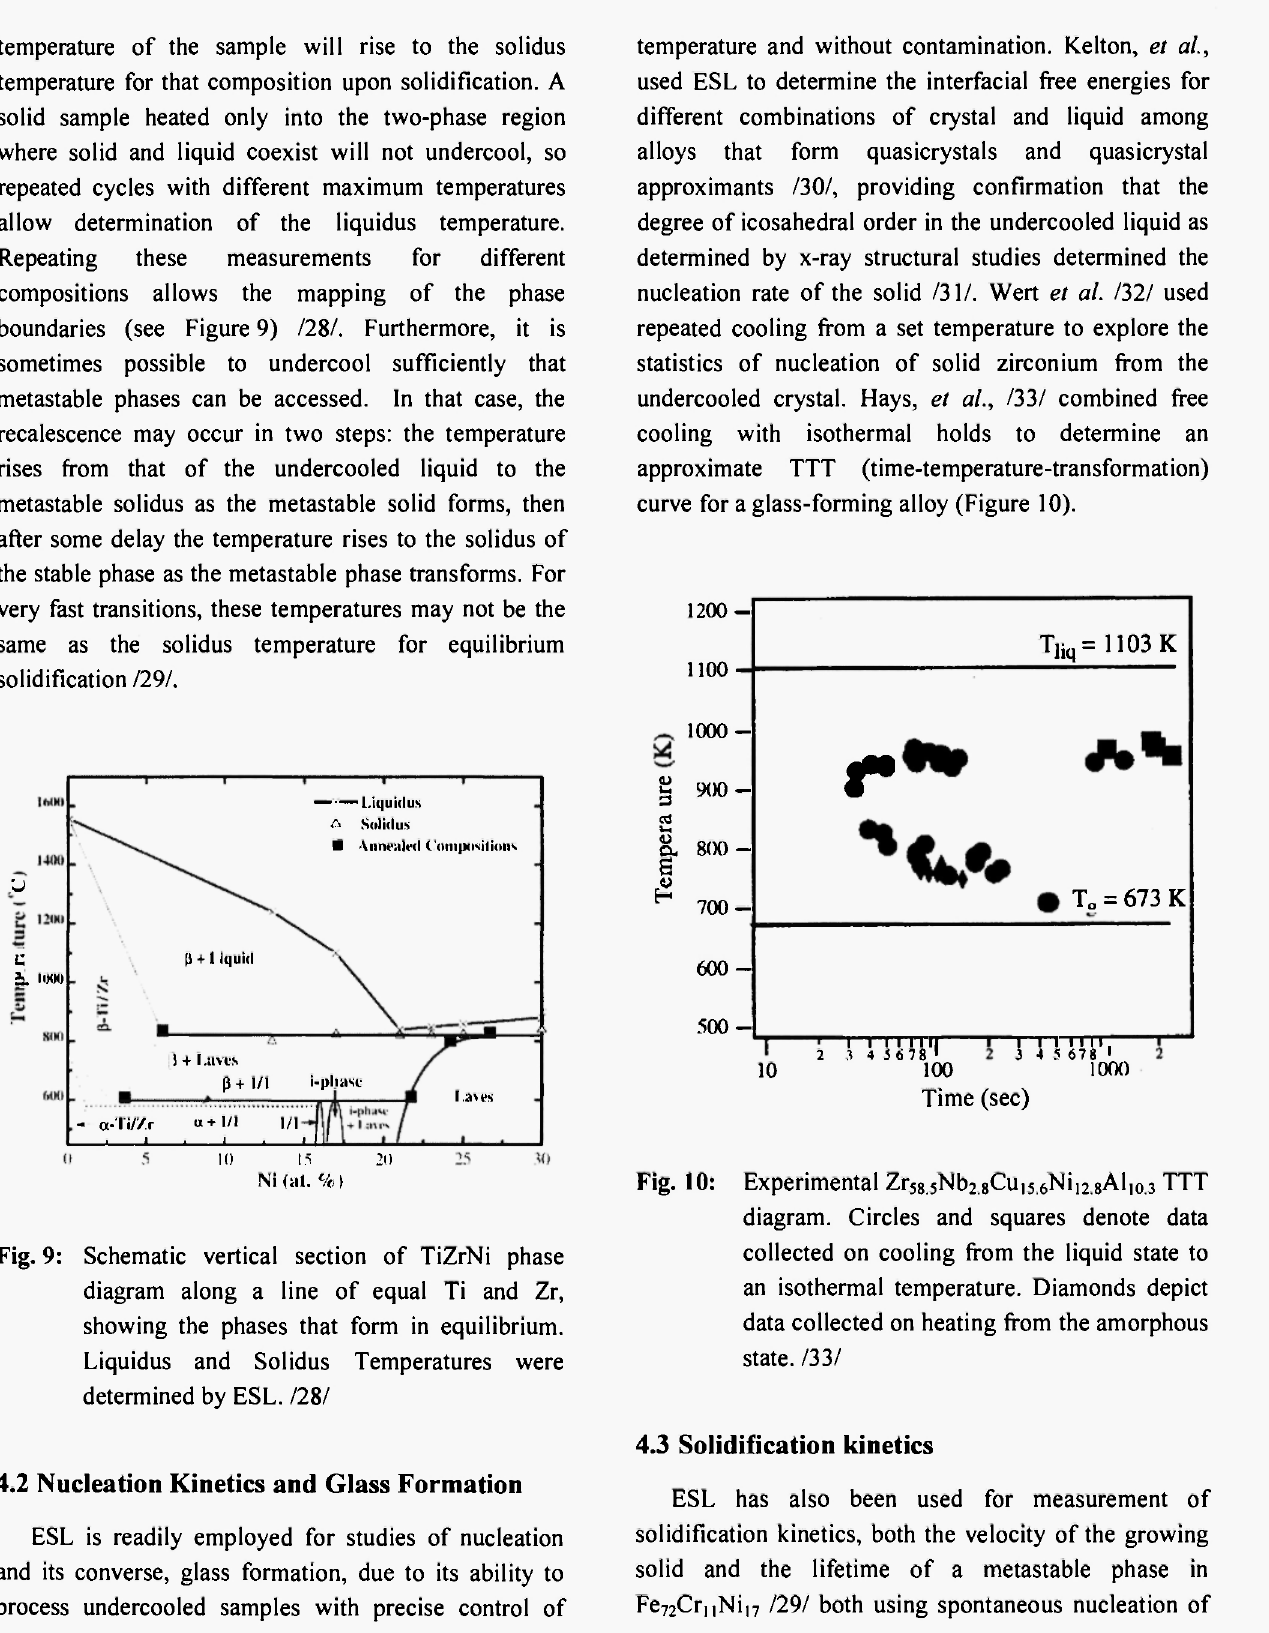
diagram. Circles and squares denote data collected on cooling from the liquid state to an isothermal temperature. Diamonds